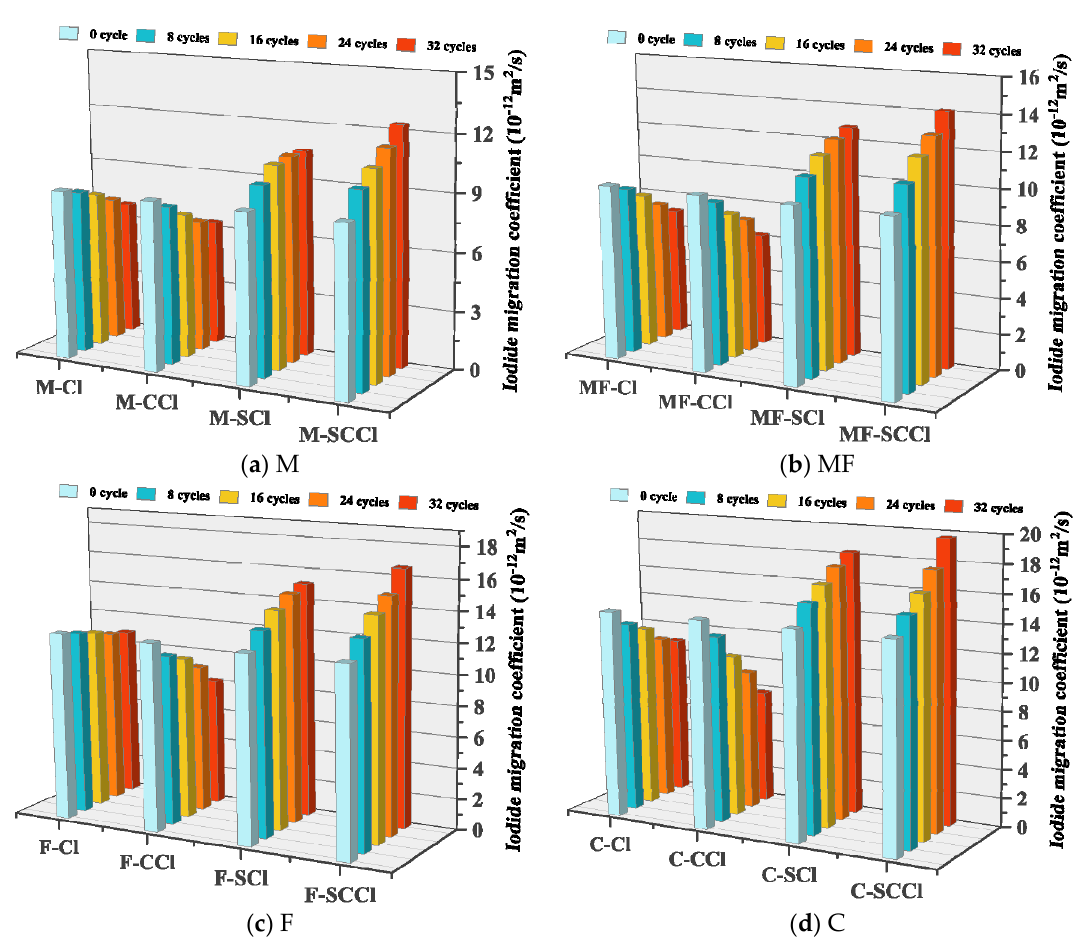
Figure 8. Internal migration properties of iodide ions in concrete after different environmental ero-